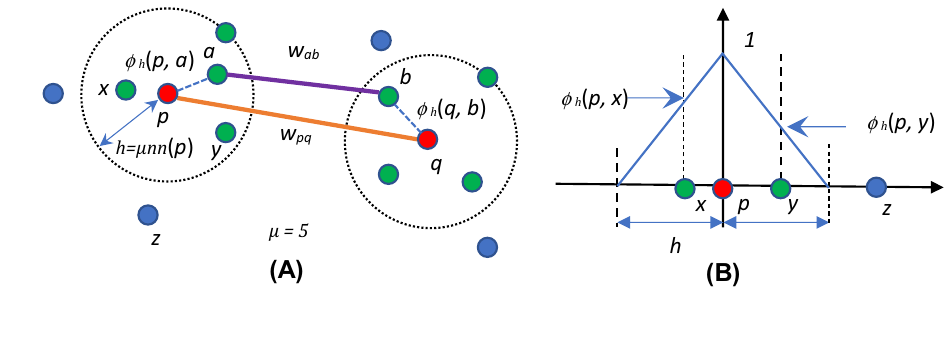
Fig. 3 a Constraint inherit- ance from ( p , q ) to ( a , b ). b The effect of the object b on its